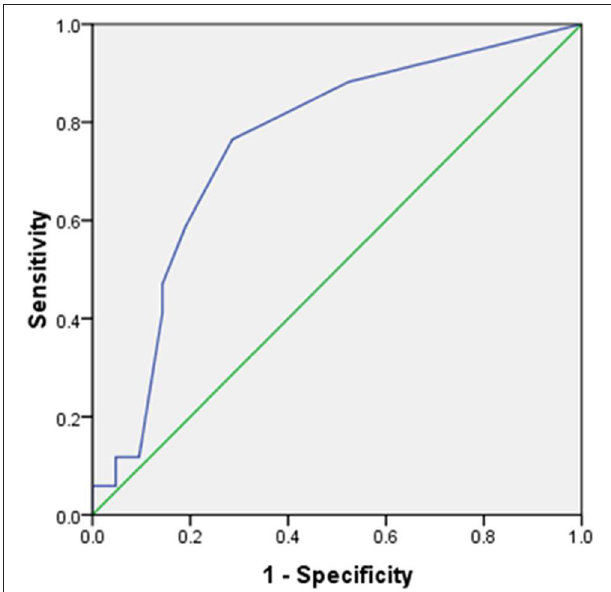
FIGURE 2 | Receiver operating characteristics (ROC) curve for total power at presentation vs. response to initial treatment. AUC 0.755 (95% CI 0.6–0.92); p = 0.008. At a cut-off of < 2/20, total motor power at presentation predicted initial treatment failure with 76.5% sensitivity, 71.5% specificity.